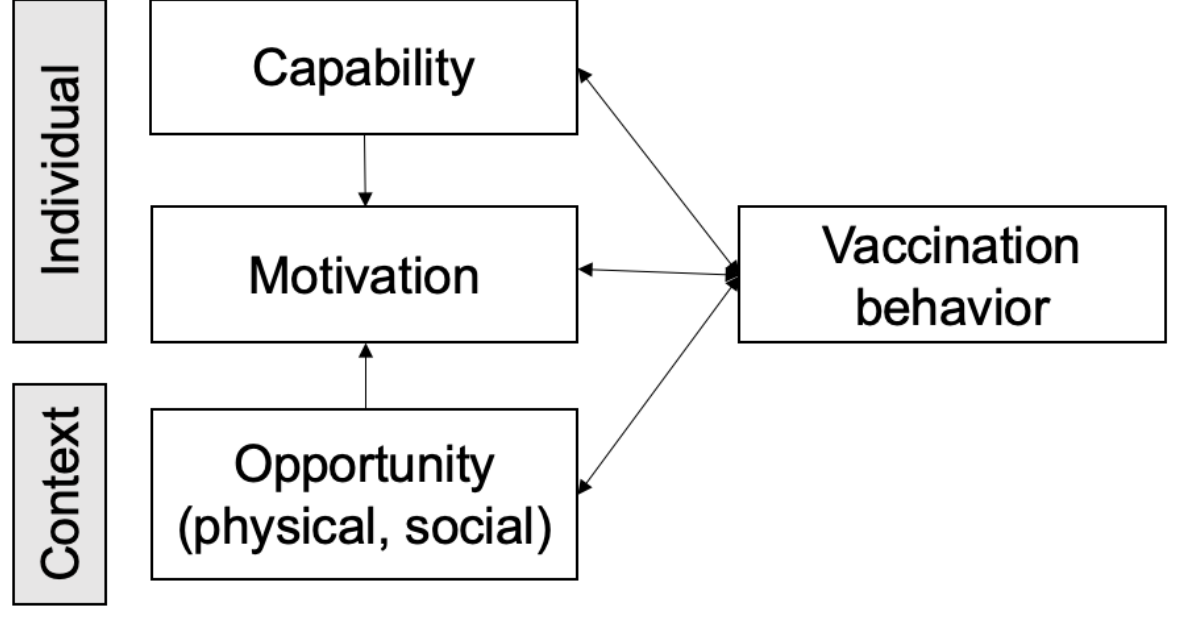
Figure 1. The theoretical model based on the capability, opportunity, motivation—behavior (COM-B) model adapted to vaccination behavior, developed by the World Health Organization Regional Office for Europe [24,25].